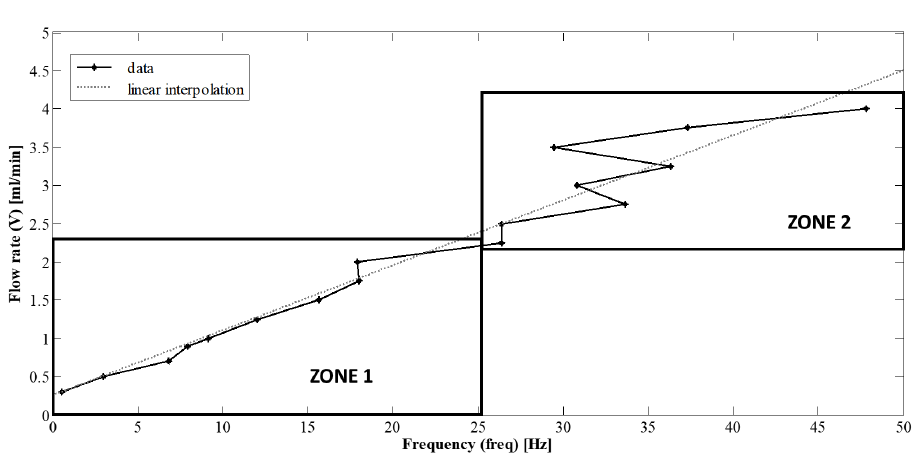
Figure 7. The peaks detected per experiment ( freq ) are plotted in function of the manipulation variable ( V ). Two zones are distinguishable: the zone-1, that shows a regular behaviour and a more irregular part, named